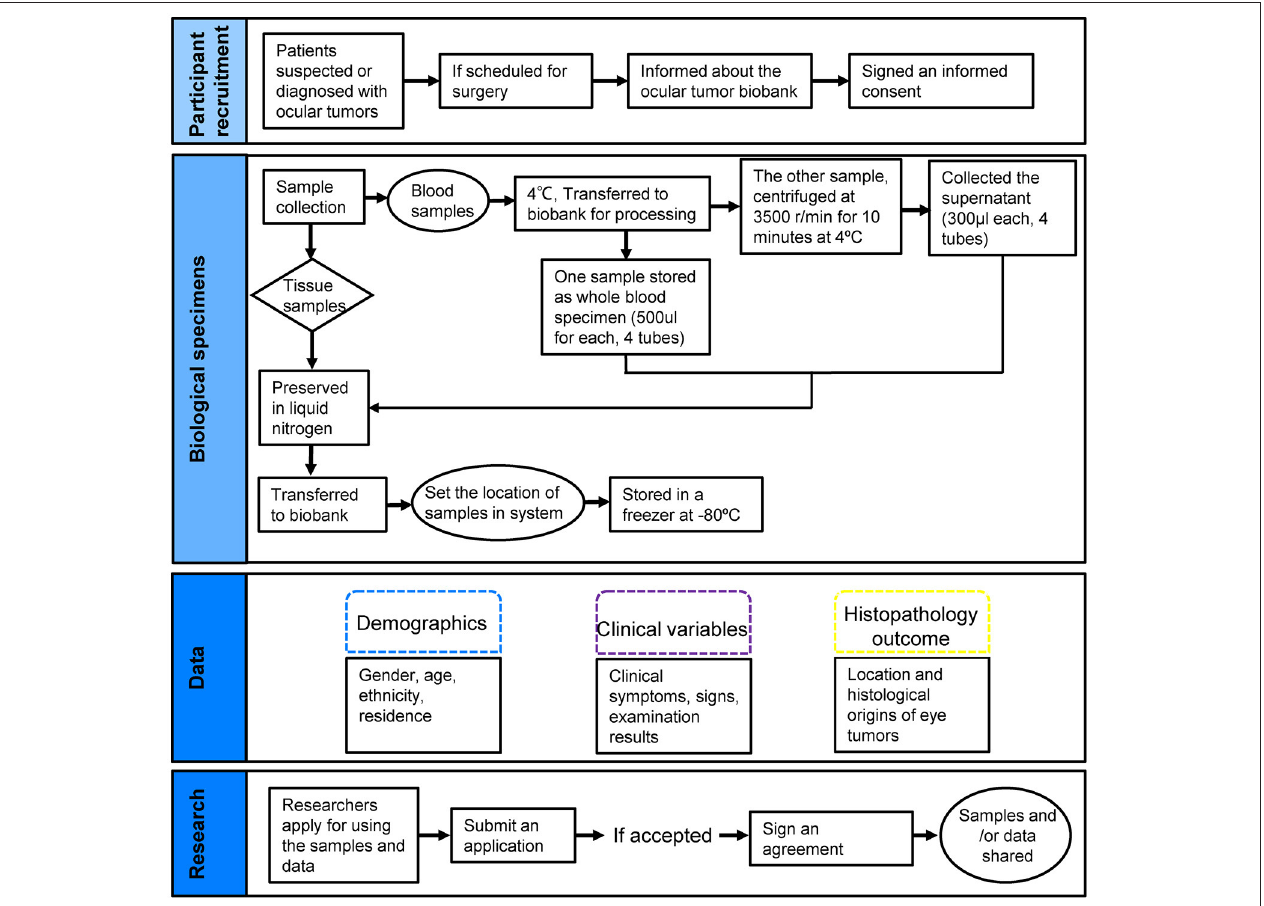
FIGURE 1 | Presentation of the ocular tumor biobank